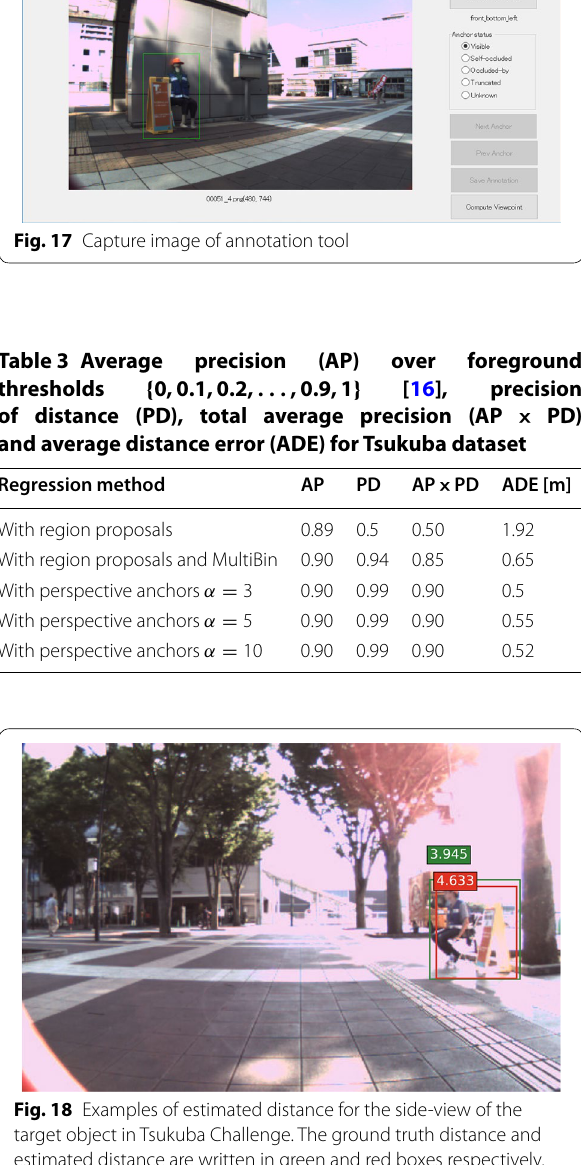
Coordinate transform node as shown in Fig. 21. The Faster R-CNN node is to run our proposed method on Jetson TX1 and to publish the information of detected BB and its distance. Meanwhile, the coordinate transform